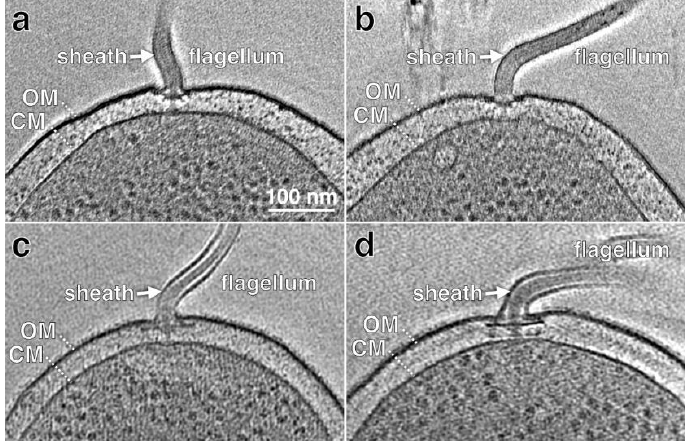
Figure 1. Cryot-ET reconstructions of intact cells show sheathed flagella. ( a,b ) Two representative sections from cryo-ET reconstructions of V. cholerae cells. ( c,d ) Two representative sections from cryo-ET reconstructions of H. pylori cells. The arrows indicate the flagellar sheath. For each flagellum, note the central core that consists of the hook and filament. The outer (OM) and cytoplasmic membranes (CM) are indicated.